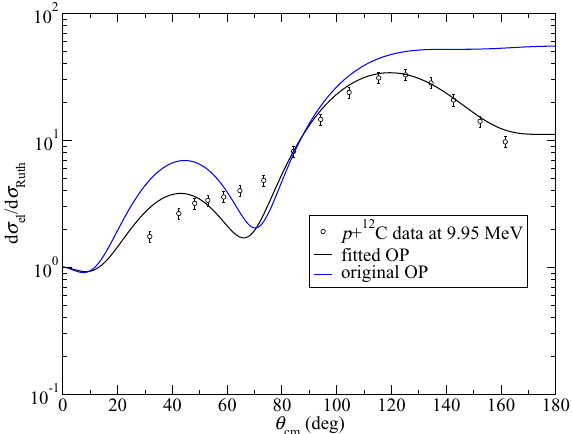
Figure 1. The elastic scattering angular distribution of 17 F + 12 C at 170 MeV. The solid squares denote the experimental data ex- tracted from Ref. [15]. The curves represent the results of the CDCC and 1-ch calculations. For the 1-ch calculations, the pro- Figure 2. The elastic scattering angular distribution of proton on ton OP used is the global or fitted one. 12 C target at 9.95 MeV. The circles denote the experimental data extracted from Ref. [21]. The curves are the OM calculation with di ff erent OPs. Figure 3. The elastic scattering angular distribution of 17 F + 12 C